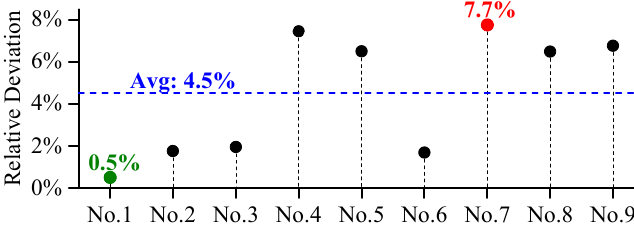
Figure 4. Relative deviations between simulated values and calculated